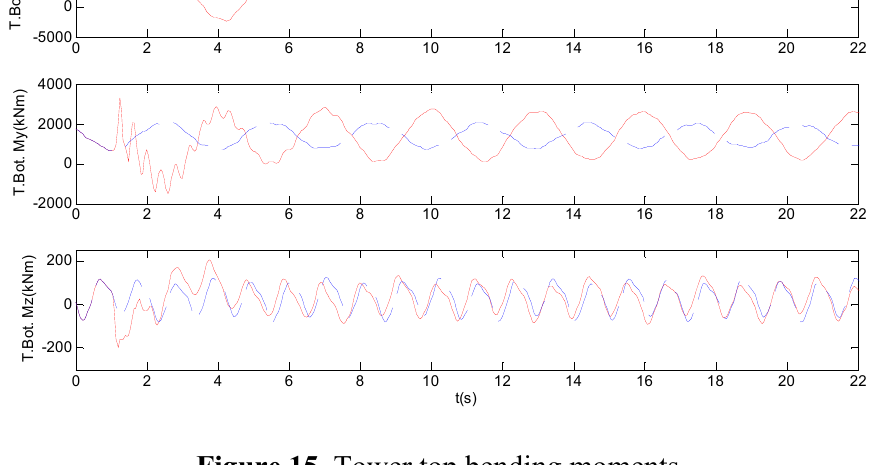
Figure 15. Tower top bending moments.